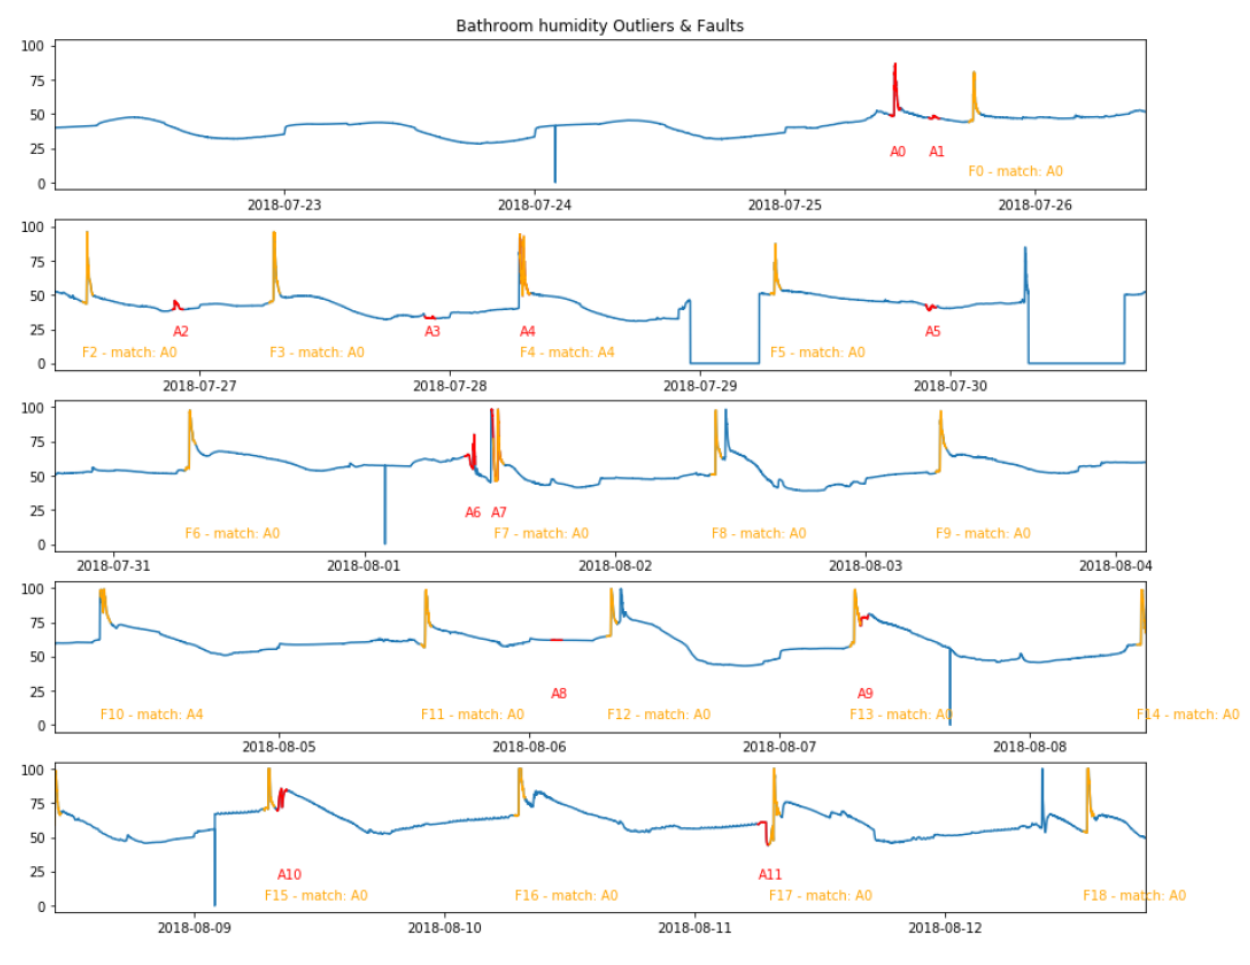
Figure 6. Bathroom humidity over a period of 21 days. Red fragments (“A”) indicate events detected by the unknown pattern detector from Section 5. After a user confirms events A0 and A4, seventeen similar segments are found by the known pattern detector (orange, “F”). This mechanism can greatly reduce labeling